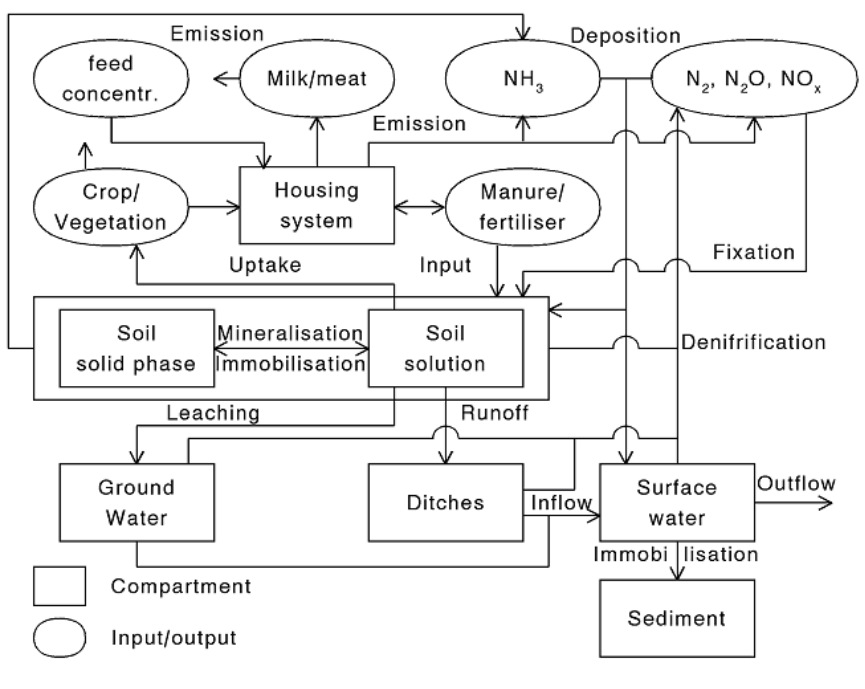
FIGURE 1. Overview of the N inputs and N processes in terrestrial and aquatic ecosystems considered in